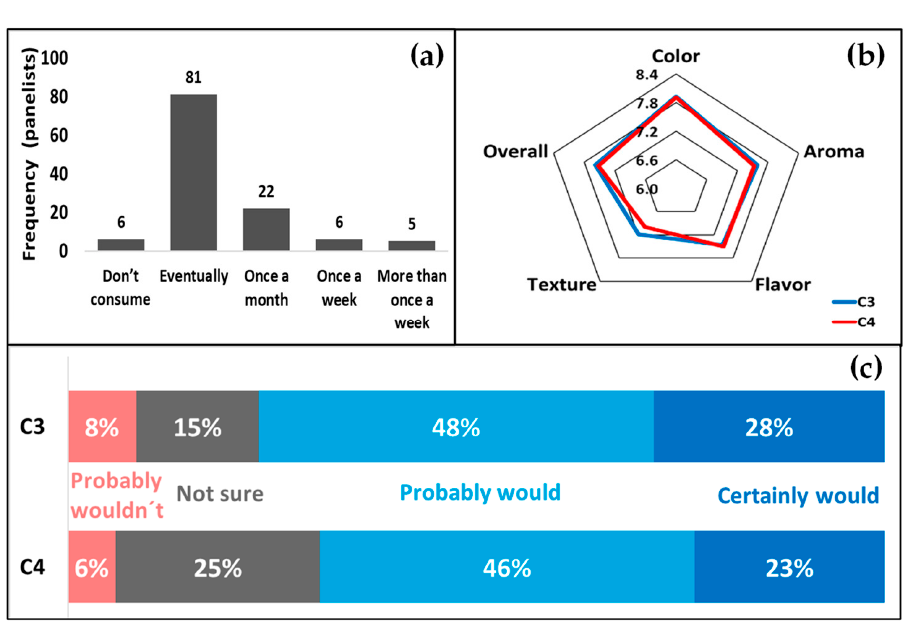
Figure 5. Frequency that the panelists consume pound cake ( a ); response to affective sensory evaluation with respect to the attributes color, aroma, taste, texture, and overall impression ( b ); and purchase intentions ( c